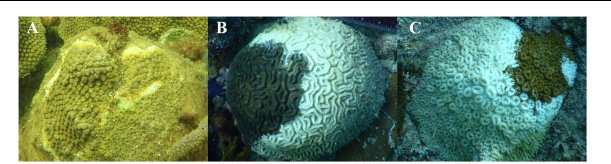
FIGURE 1 | Stony coral tissue loss disease appearance in three coral species from the Florida Reef Tract: Montastraea cavernosa (A) , Diploria labyrinthiformis (B) , and Dichocoenia stokesii (C)